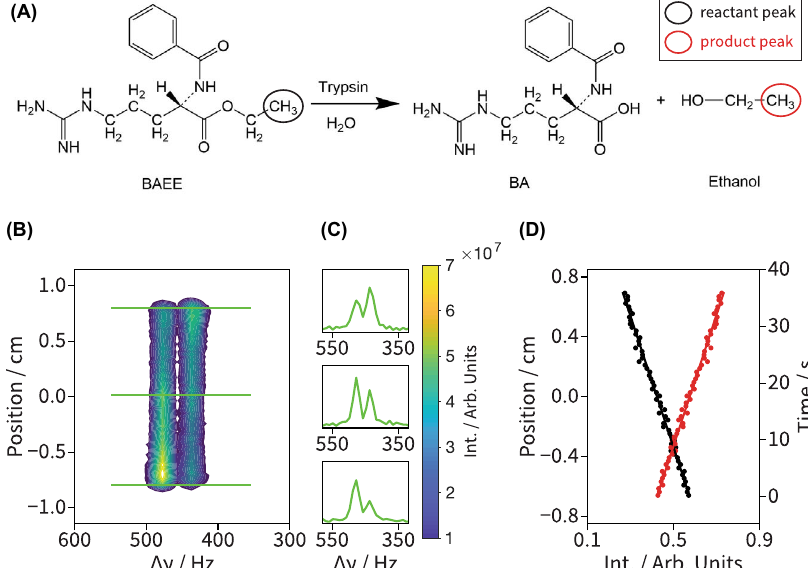
Fig. 2 Kinetic analysis of an enzymatically-catalyzed reaction recorded under continuous fl ow, off-equilibrium conditions via 2D spectrotemporal correlations. A Chemical structures of the substrate N - α -benzoyl arginine ethyl ester (BAEE), and reaction products benzoyl arginine (BA) and ethanol. The CH 3 groups monitored in the experiments are circled in black and red for the reactant and product, respectively. B 1 H EPSI NMR spectrum of 10 mM BAEE reacting with 7.5 µ M trypsin using the pulse sequence in Fig. 1D ( T a = 0.5 ms, N EPSI = 100, Δ z = 230 μ m, v = 0.33 mL/min, Δ t R = 580 ms); C green plots show three spectral cross sections taken at the indicated line positions (also green). D Integrated spectral intensities (circles) of the reactant (black circles) and product (red circles) resonances plotted against position within the coil. The known rate of fl ow permits translating positions into reaction times; kinetic fi tting of the integrated intensities as discussed in the main text leads to the red and black solid lines, which yielded k cat = 11.8 ± 0.5 s − 1 and t 0 = 48 ± 3 s for three consecutive acquisitions. A relaxation delay of 5 s and 64 scans were used in these